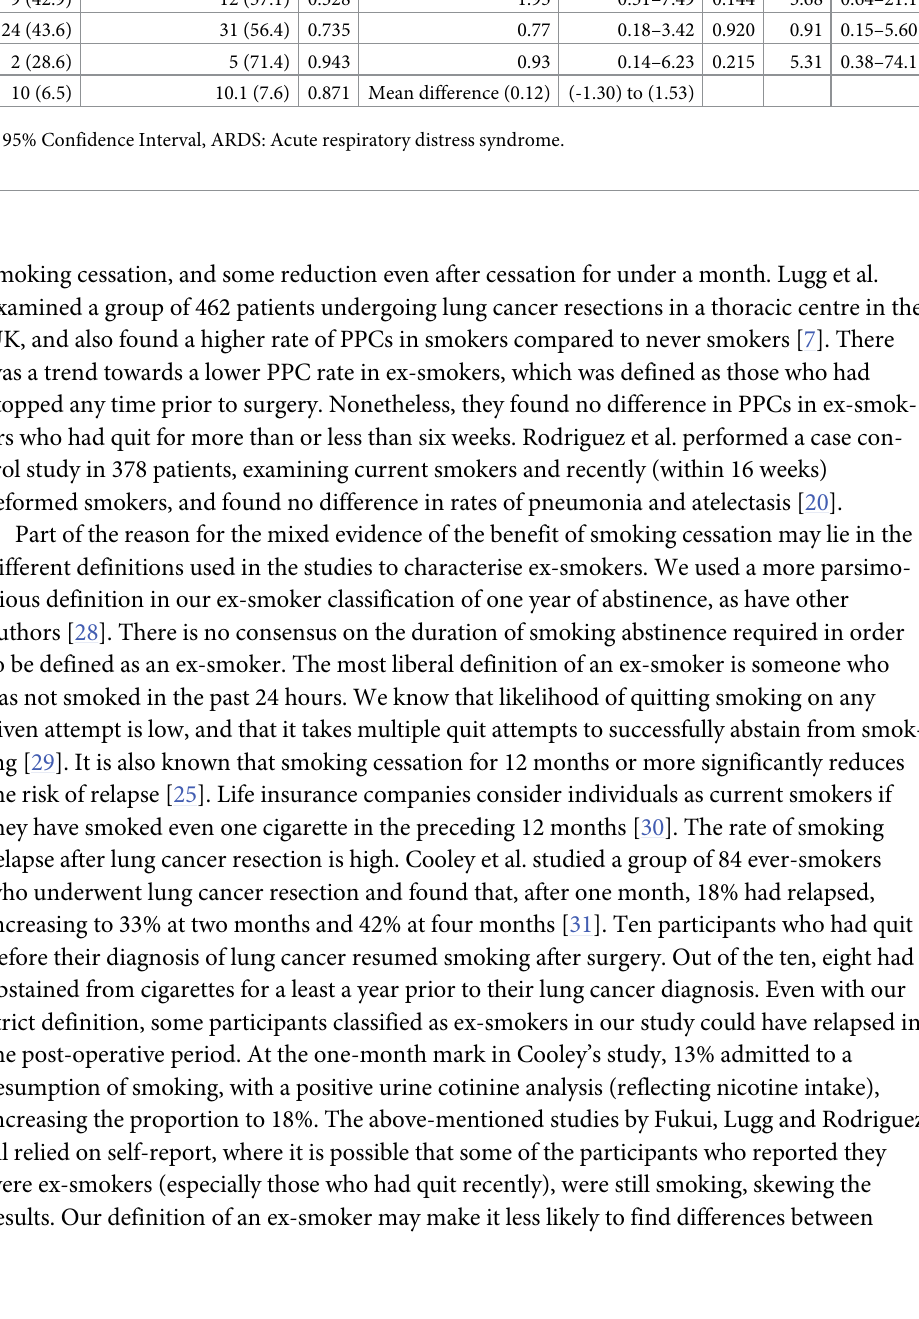
OR: Odds Ratio, AOR: Adjusted Odds Ratio, 95%CI: 95% Confidence Interval, ARDS: Acute respiratory distress syndrome. � Adjusted for: age, gender and